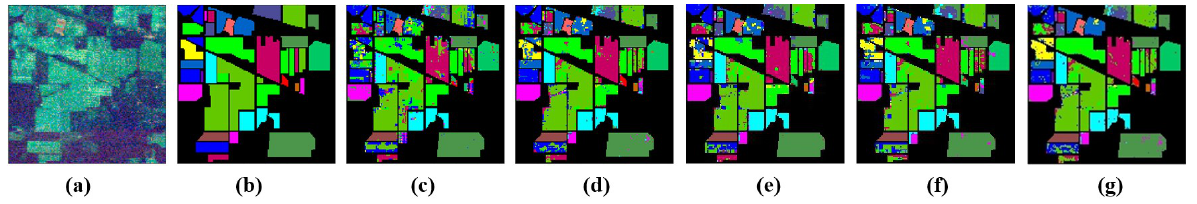
Figure 10. Classification maps of different models for Indian Pines dataset: ( a ) false color composite image; ( b ) ground truth; ( c ) SS3FCN; ( d ) TAP-Net; ( e ) DA-IMRN (sub-net1); ( f ) DA-IMRN (sub-net2); ( g )